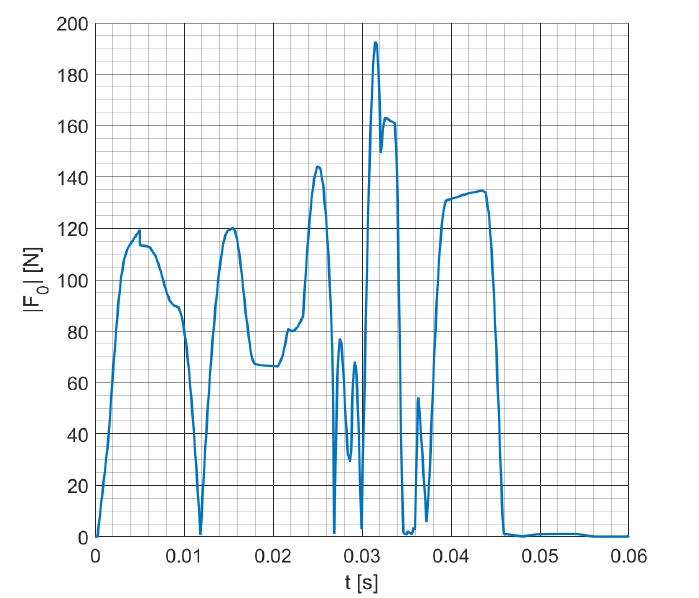
Figure 4. Magnitude of the base force F 0 for a single operating